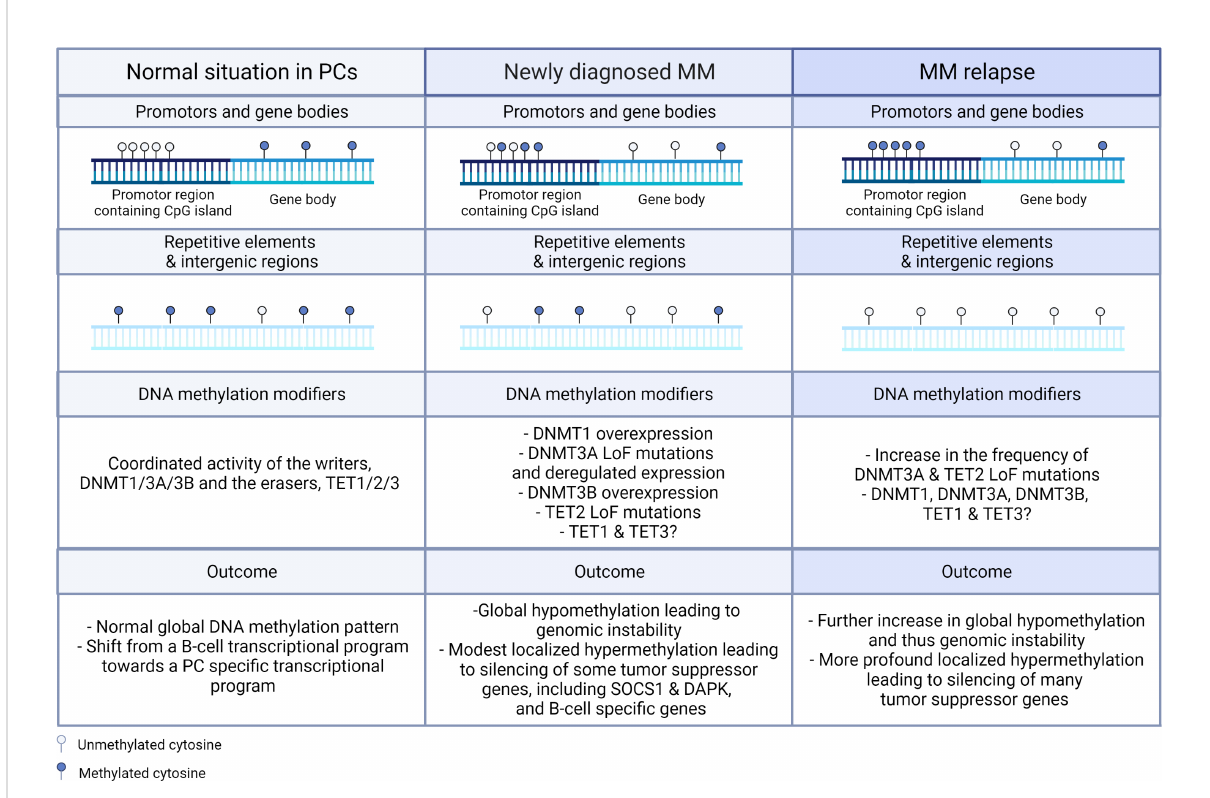
FIGURE 2 Schematic representation of the changes in global and gene speci fi c DNA methylation patterns and DNA methylation modi fi ers in newly diagnosed and relapsed MM. In normal circumstances, CpG islands found in the promotor regions are in general not methylated, while the CpG dinucleotide in gene bodies, intergenic regions, and repetitive elements are mostly methylated. In MM, global hypomethylation is found in gene bodies, intergenic regions, and repetitive elements, while hypermethylation is observed in the CpG islands found in the promotor regions of tumor suppressor genes. In the relapsed settings, these events are even more pronounced. On the levels of the DNMT and TET enzymes, overexpression of DNMT1 and DNMT3B and loss-of-function (LoF) mutations in DNMT3A and TET2 are observed in newly diagnosed patients and the frequency of the LoF mutations in DNMT3A and TET2 are even further increased in the relapse setting. In healthy PCs, normal global methylation patterns are observed with a shift from the B-cell transcriptional program towards the PC speci fi c transcriptional program, while in MM cells global hypomethylation leading to genomic instability and localized hypermethylation leading to silencing of tumor suppressor and B- cell speci fi c genes are observed. PC, plasma